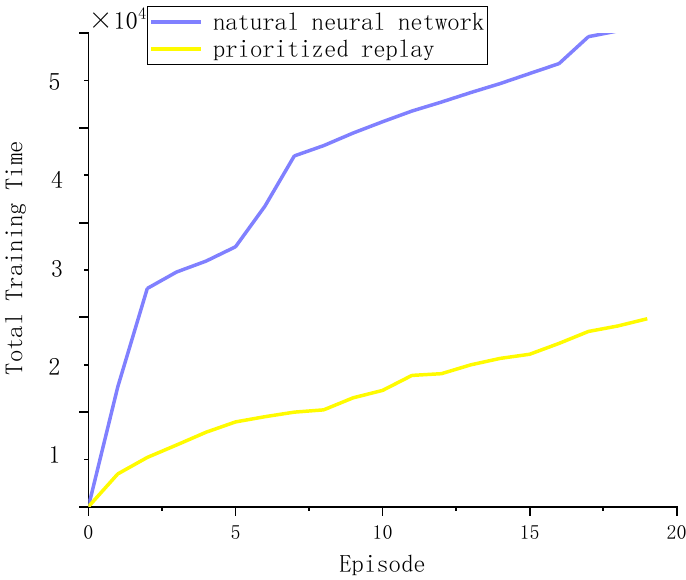
Figure 11. Comparison of neural network incorporation priority experience playback results.